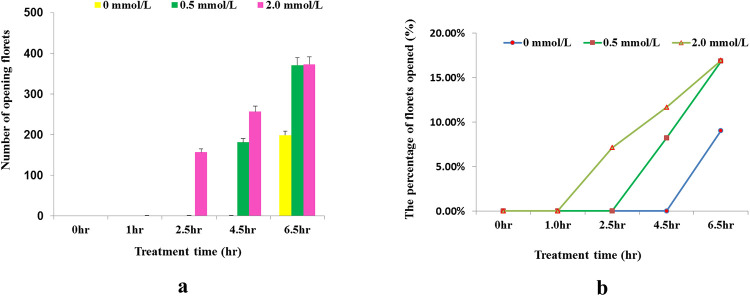
Florets opened in abundance after the treatments.a, The number of florets opened after the treatments. b, The percentage of florets opened after the treatments. In figure a and b, X-axis represents the duration of treatment from 18:00 PM at which time point the treatments were conducted. Y-axis represents the number of opening florets and the percentage of open florets in figure a and b, respectively. After 2.5h of the treatment, the florets began to opening in abundance, and the higher the concentration of MeJA, the more florets opened.